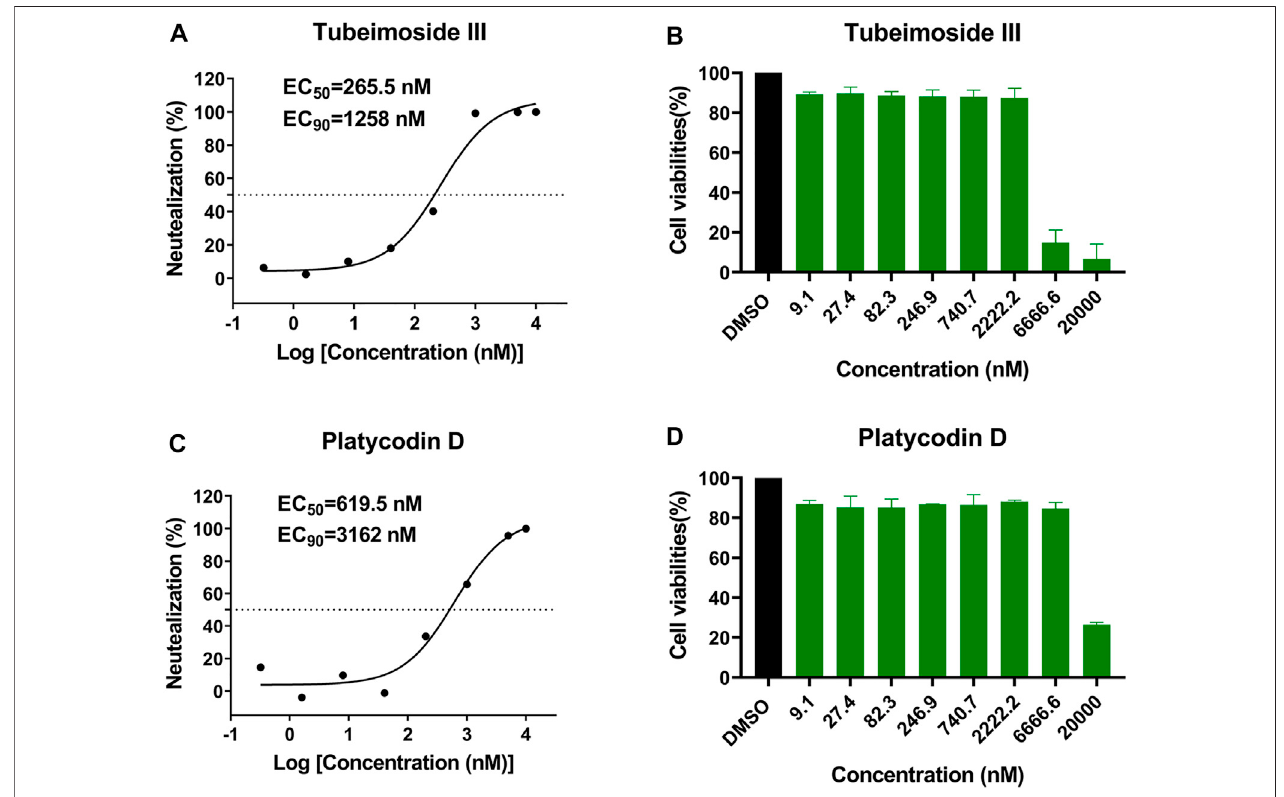
FIGURE4| TheantiviralactivitiesofPlatycodin_DandTubeimoside_IIIagainstSARS-CoV-2andcytotoxicityinVerocell. (A,C) VerocellswereinfectedwithSARS- CoV-2atanMOIof0.02inthepresenceoftheindicatedconcentrationsofthetesteddrugsfor48 h,andtheviralyieldinthecellsupernatantwasthenquanti fi edbyqRT- PCR.Thedose-responsecurveswereplottedfromviralRNAcopiesversusthedrugconcentrationsusingGraphPadPrism8software. (B,D) Verocellsgrownin96-well plates were treated with various concentrations of compounds or mock-treated for 24 h, followed by 4 h incubation in the media supplemented with 10% CCK-8. Viable cells were counted according to the absorbance at 450